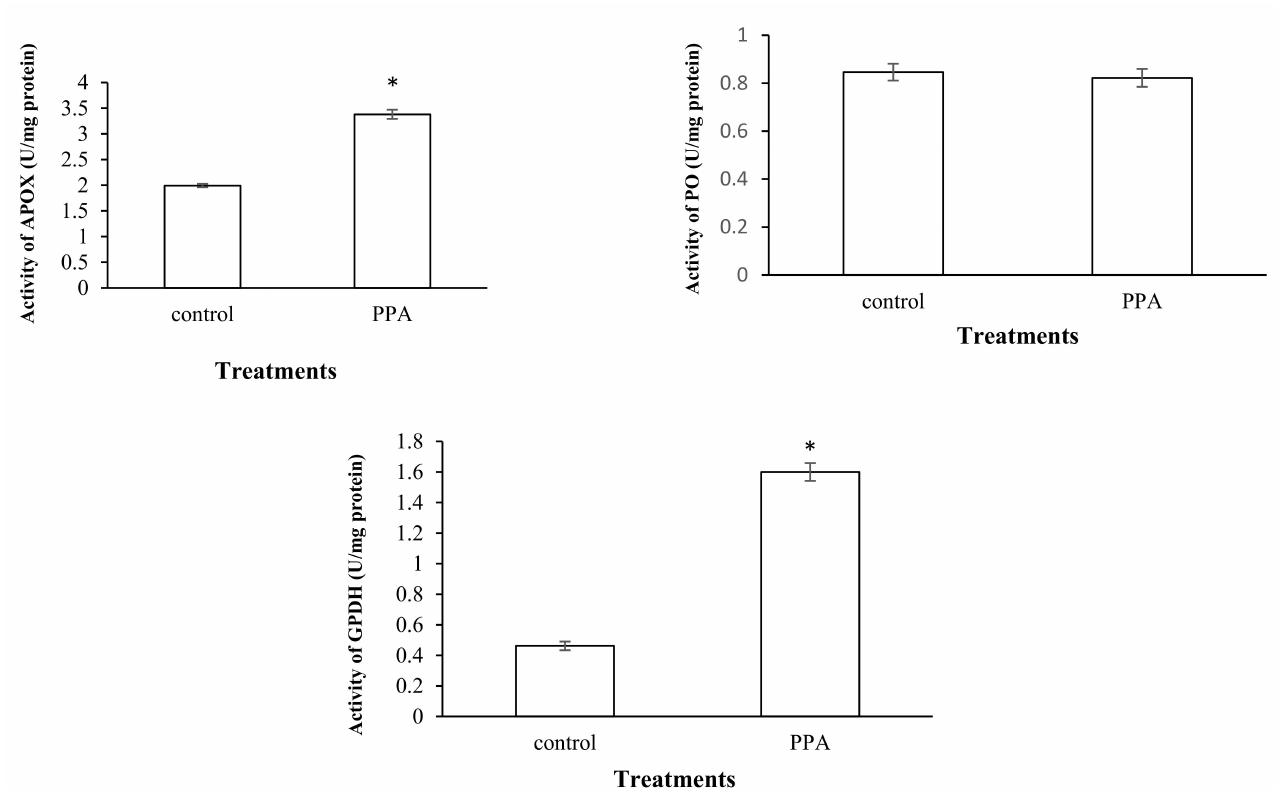
Figure 5. Activities of antioxidant enzymes in control and PPA-treated adults of Sitophilus oryzae : ascorbate peroxidase (APOX); peroxidase (PO); glucose 6-phosphate dehydrogenase (GPDH). Statis- tical differences have been marked by asterisks ( t -test, p ≤ 0.05). * indicate significant deference.